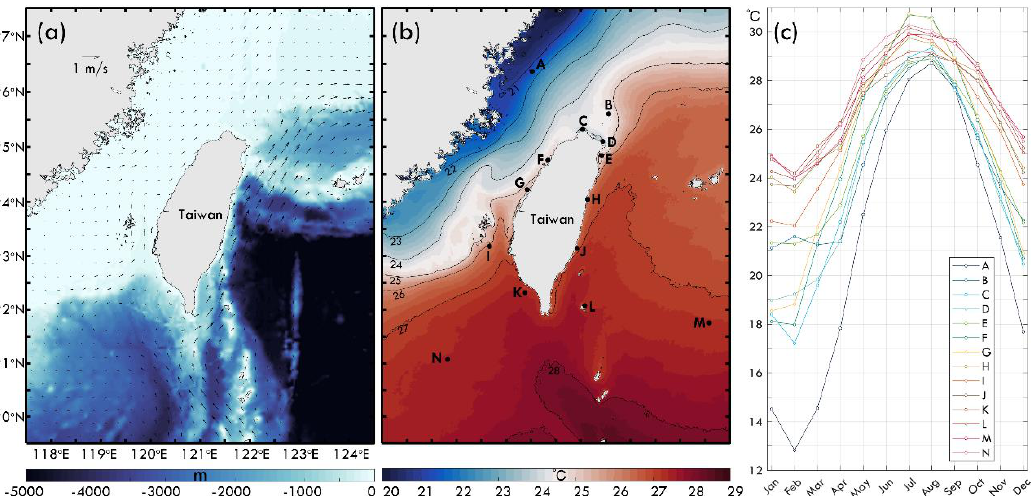
Figure 1. ( a ) The study area and the long-term average ocean geostrophic currents from July 2015 to May 2022, ( b ) the long-term average SST derived by the Himawari-8 satellite from August 2015 to April 2022, and ( c ) the climatological monthly average SST from the Himawari-8 satellite at each station in Figure 1b from August 2015 to April